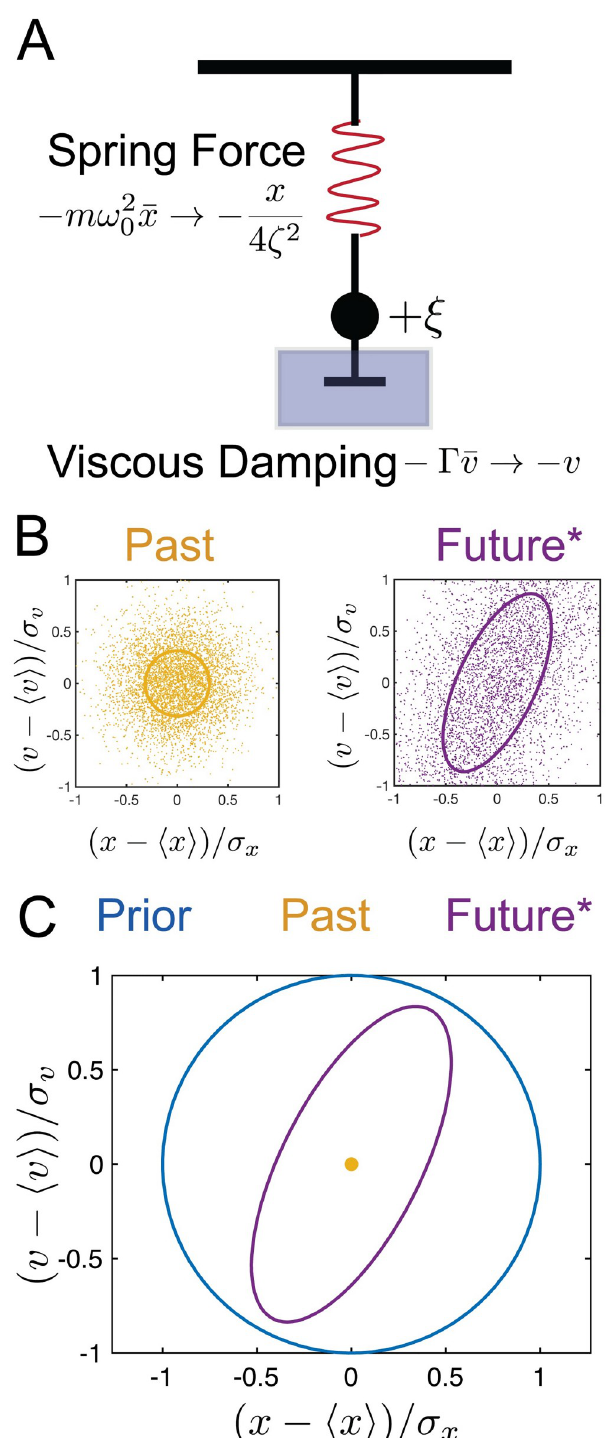
Fig 2. Schematic of the stochastically driven damped harmonic oscillator (SDDHO). (a) The SDDHO consists of a mass attached to a spring undergoing viscous damping and experiencing Gaussian thermal noise of magnitude. There are two parameters to be explored in this model: z ¼ 1 distribution of the history (yellow, left) and show its time evolution (purple, right). We take 5000 samples from the distribution, at random, and let these points evolve in time according to the SDDHO equation of motion. We